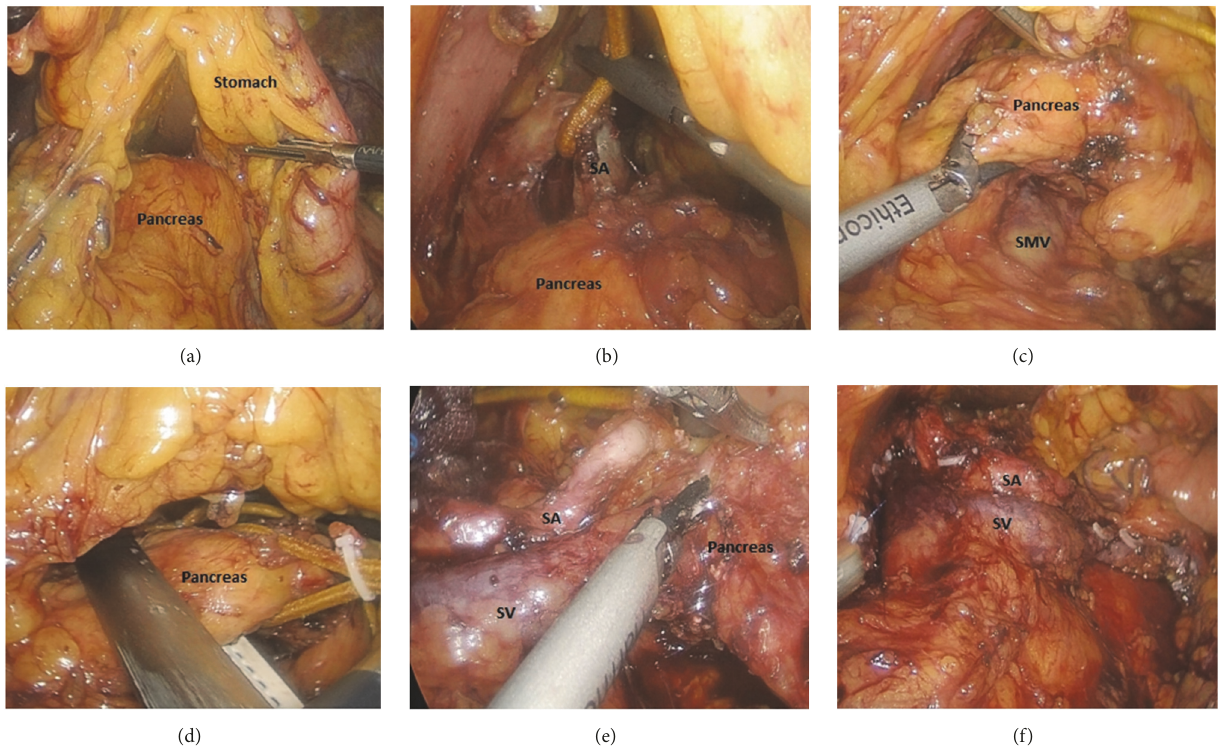
Figure 2: (a) Stomach is hanged superiorly and anteriorly from the abdominal wall. (b) Identification of the splenic artery and placement of the vascular loop around the splenic artery to provide counter traction. (c) Dissection of the inferior-posterior margin of the pancreas to expose superior mesenteric vein (SMV), inferior mesenteric vein (IMV), and the splenic vein. (d) The neck of pancreas is divided with a endoscopic stapler. (e) Dissection of the dorsal side of the pancreas, pulling of the distal pancreatic stump with body and tail to the left lateral side in order to free the splenic vessels from the distal pancreas. (f) Preservation of the splenic vein and artery (the body and tail of the pancreas are removed). SV: splenic vein, SA: splenic artery, and SMV: superior mesenteric